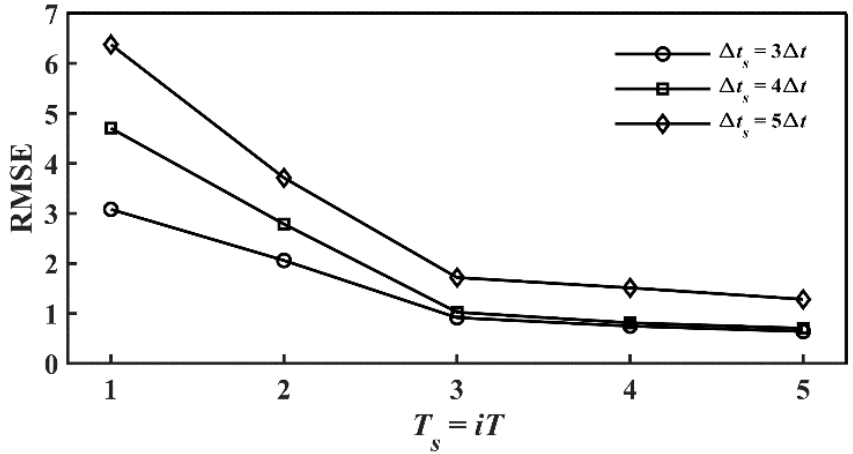
Figure 11. RMSE of the DMD reconstruction as a function of sampling interval with coverage